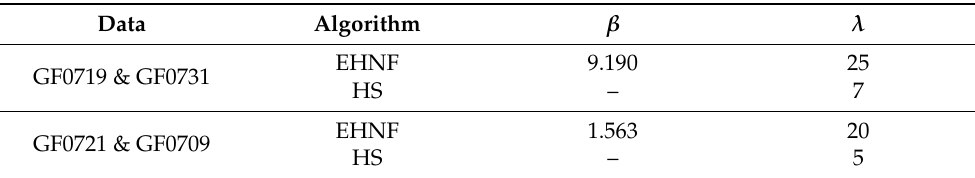
Table 2. Parameter values of the dense matching